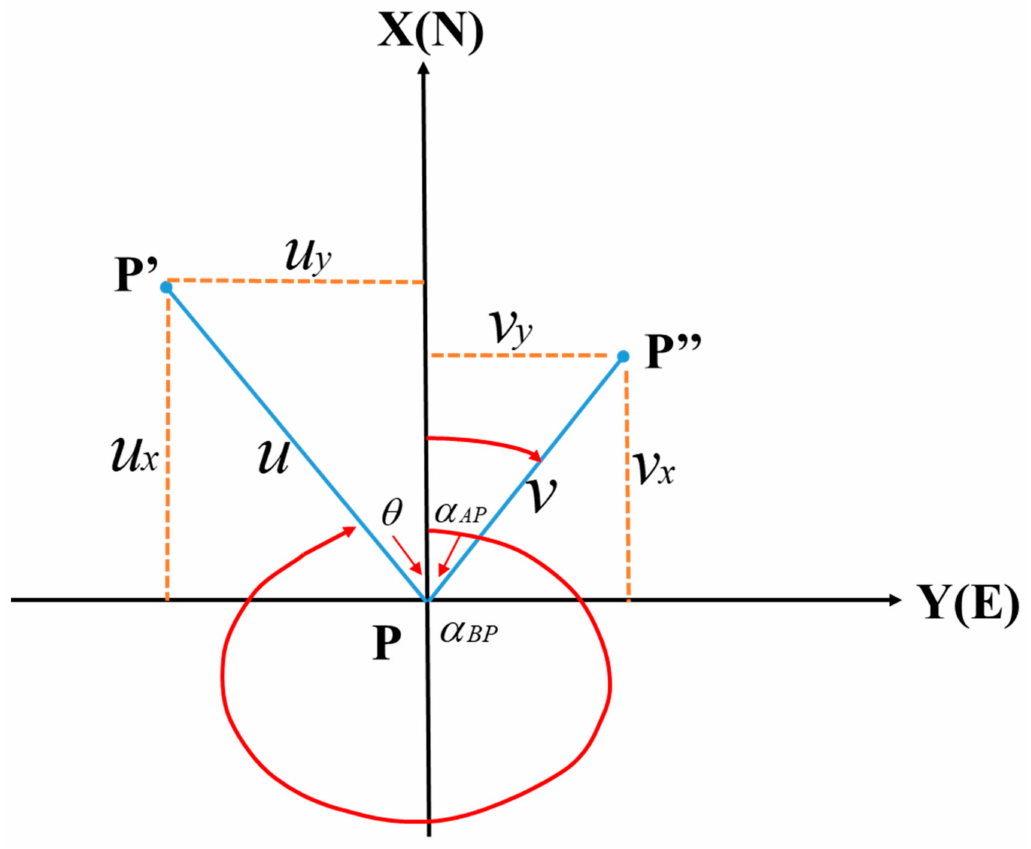
Figure 5. Schematic diagram of axis